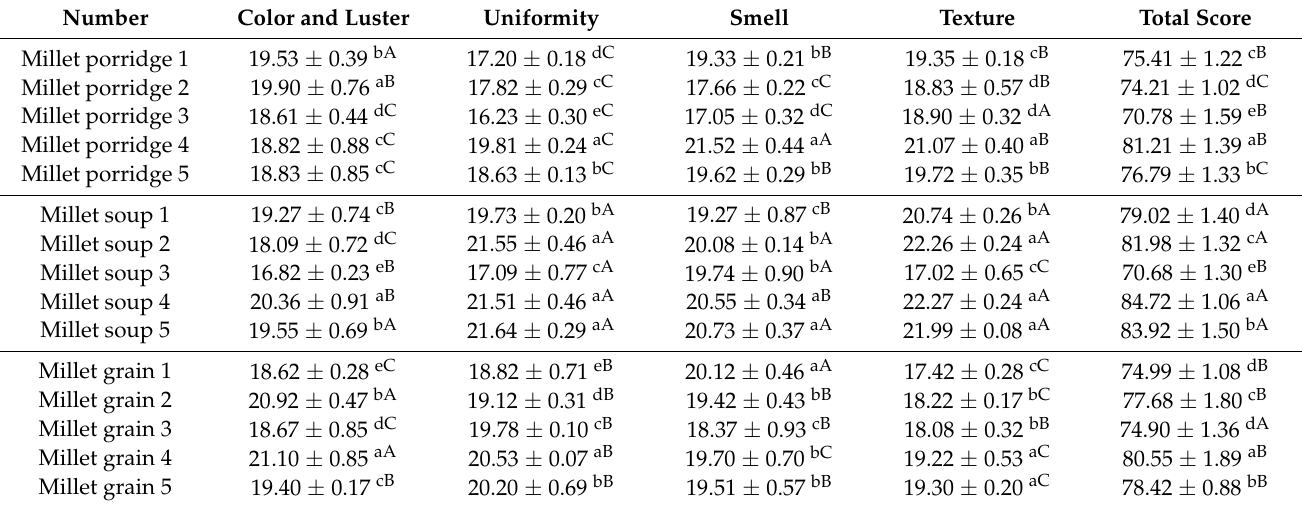
Table 2. Sensory evaluation results of samples cooked in different electric